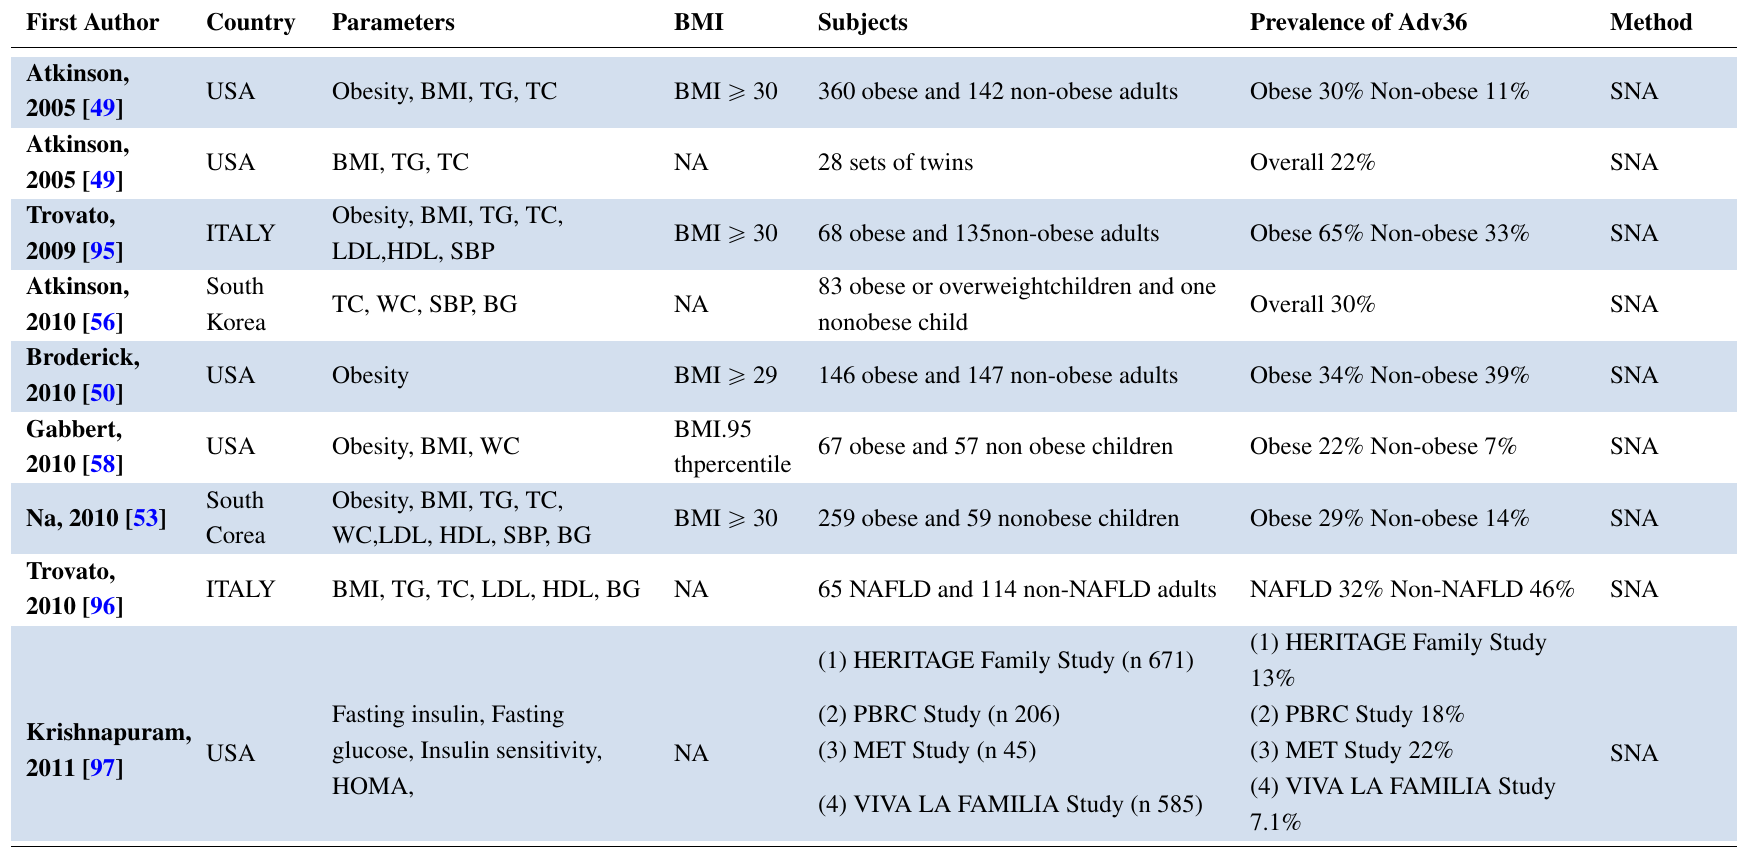
Table 1. Studies on the association of Adv36 and obesity. BMI, body mass index; TG, triglycerides; TC, total cholesterol; LDL, low density lipoprotein; HDL, high density lipoprotein; BG, blood glucose; NAFLD, Nonalcoholic fatty liver disease; SBP, systolic blood pressure; WC, waist circumstance; NA, not available; SNA, serum neutralization assay; DXA, dual-energy X-ray absorptiometry; VEGF, vascular endothelial growth factor; MCP-1, monocyte chemoattractant protein-1; TNF α , tumor-necrosis-factor-alpha; IL-6, interleukin-6; HERITAGE, HEalth, RIsk factors, exercise Training And Genetics; PBRC, Pennington Biomedical Research Center; MET, Mechanisms of the Metabolic Syndrome in Prepubertal